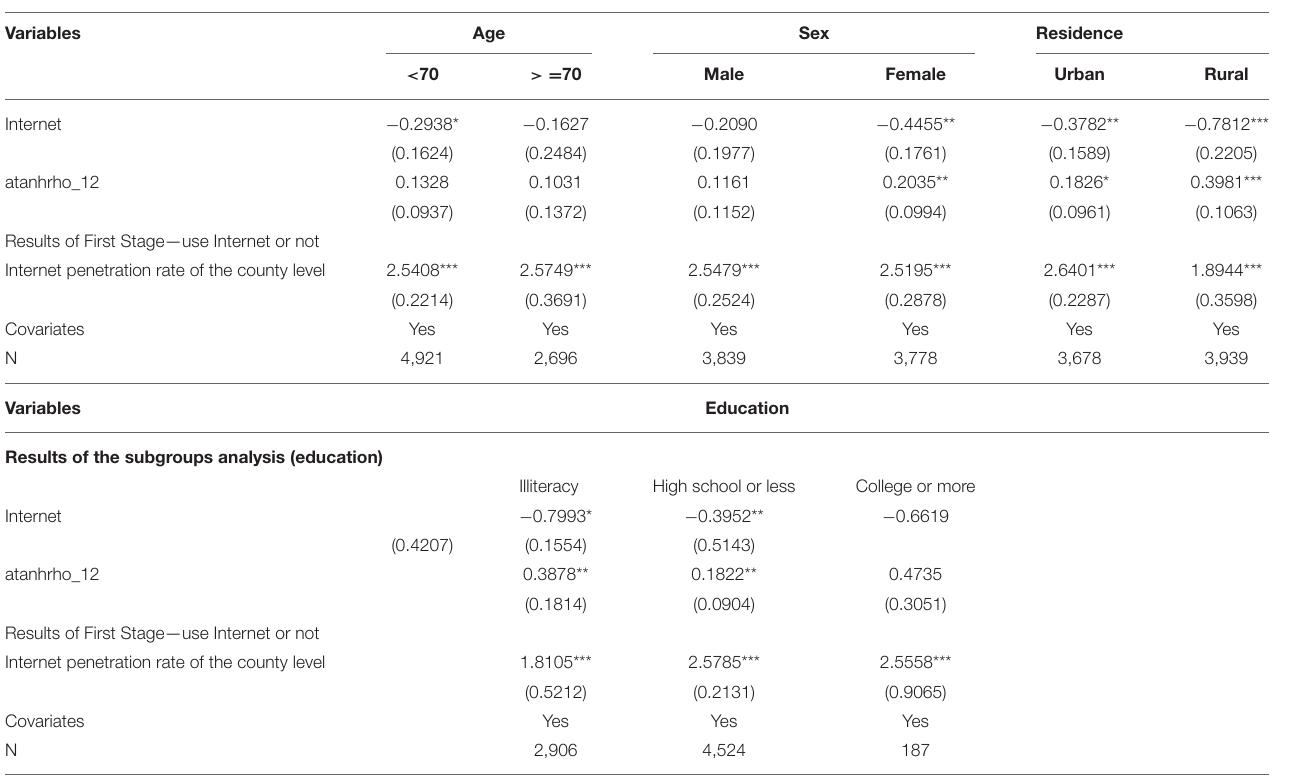
TABLE 5 | Results of the subgroups analysis (age, sex,